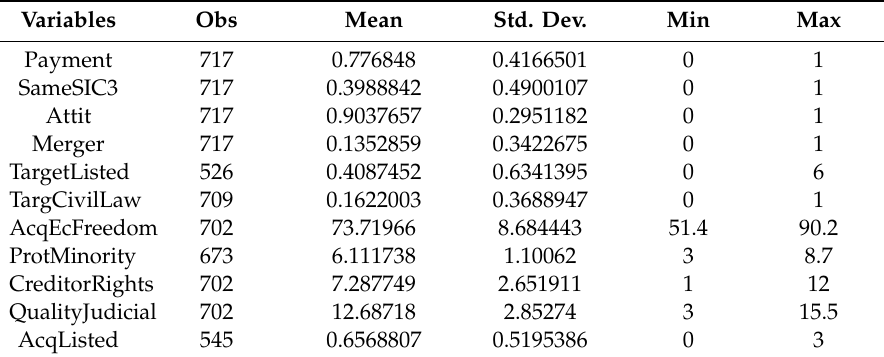
Table 3. Summary of the descriptive